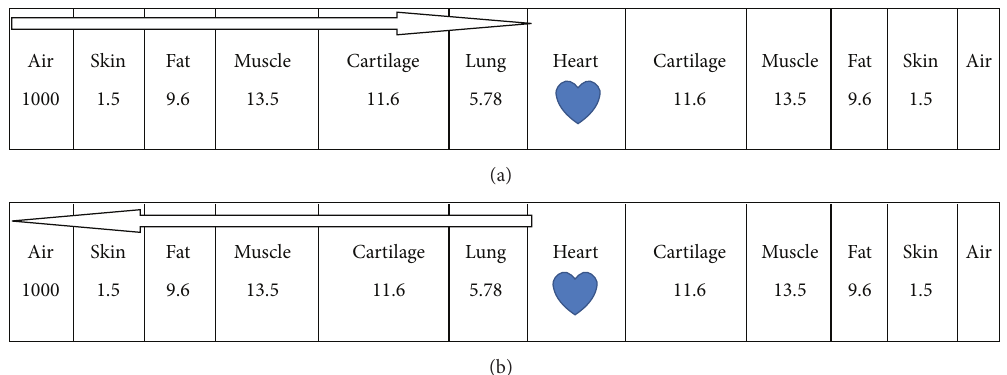
Figure 3: Tissue structure for EM modeling of human body: (a) forward propagation; (b) backward propagation. Figures in the diagram indicate the thickness of the tissue layers in millimeter.